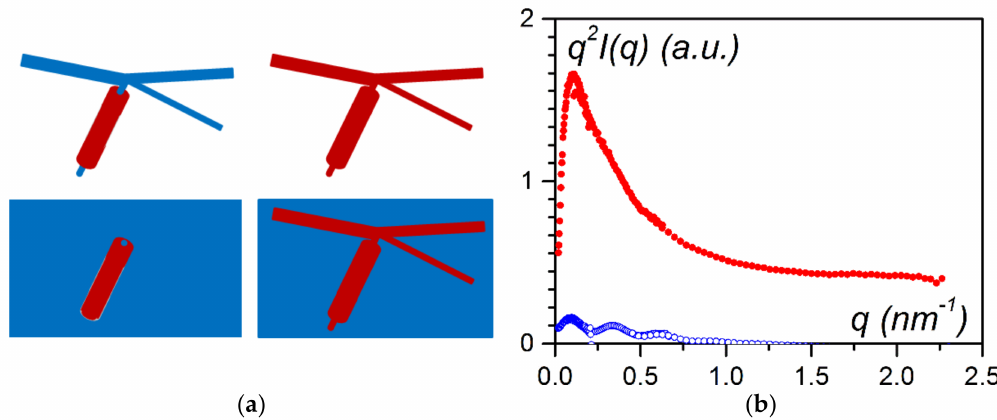
Figure 9. ( a ) Sketch of nanotubes sheathing polymer fibrils. The nanotubes are randomly oriented. The colours indicate hydrogenous species (red) and deuterated species (blue) to illustrate the contrast matching. In a deuterated solvent (blue), only the hydrogeneous species are seen. ( b ) Scattering curves for iPS D /bhpb-10/trans-decahydronaphthalene D ( ) and iPS H /bhpb-10/trans-decahydronaphthalene D (cid:35) ( ) plotted by means of a Kratky representation q 2 I(q) vs. q